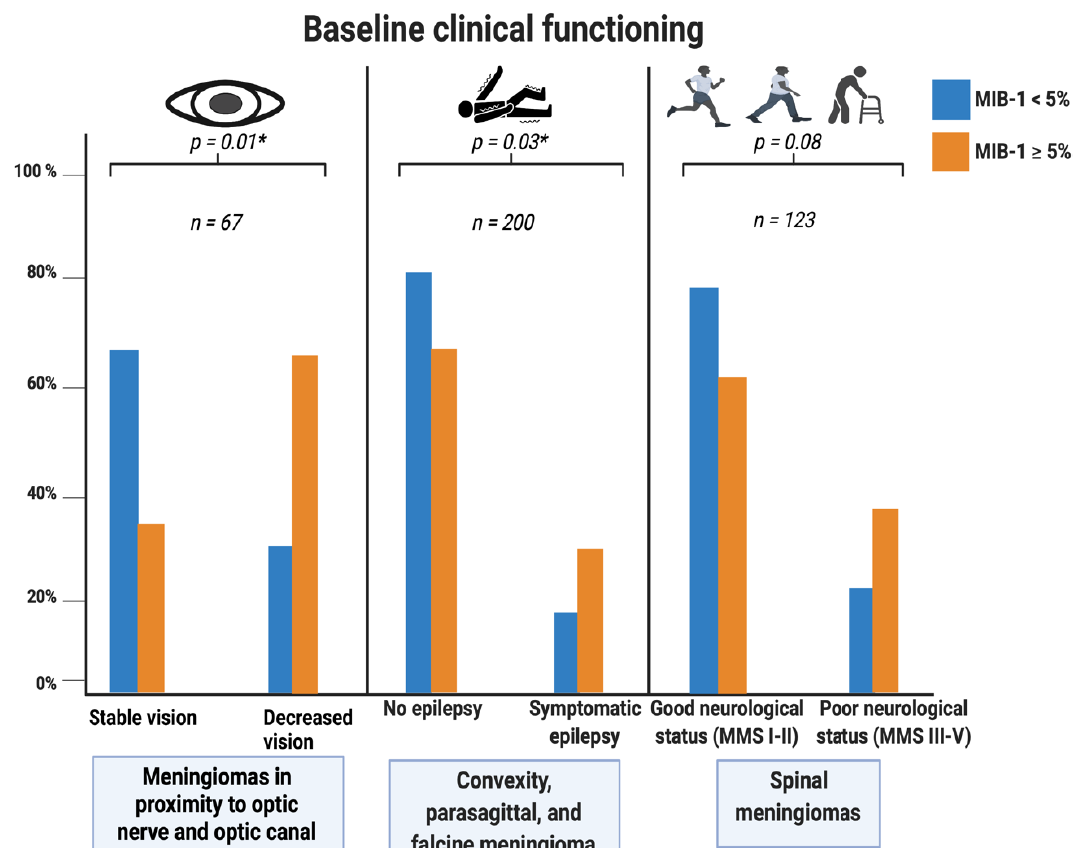
Figure 7. Grouped bar charts with percentages. Relative frequency of specific clinical dysfunctions at presentation stratified by anatomical location. Portion of meningioma patients having an MIB-1 index <5% is displayed by the blue bars, whereas the orange bars represent meningioma patients with an MIB-1 index ≥ 5%. p -values of the Pearson’s chi-squared test (two-sided) are reported. Significant p -values are marked with an asterisk.